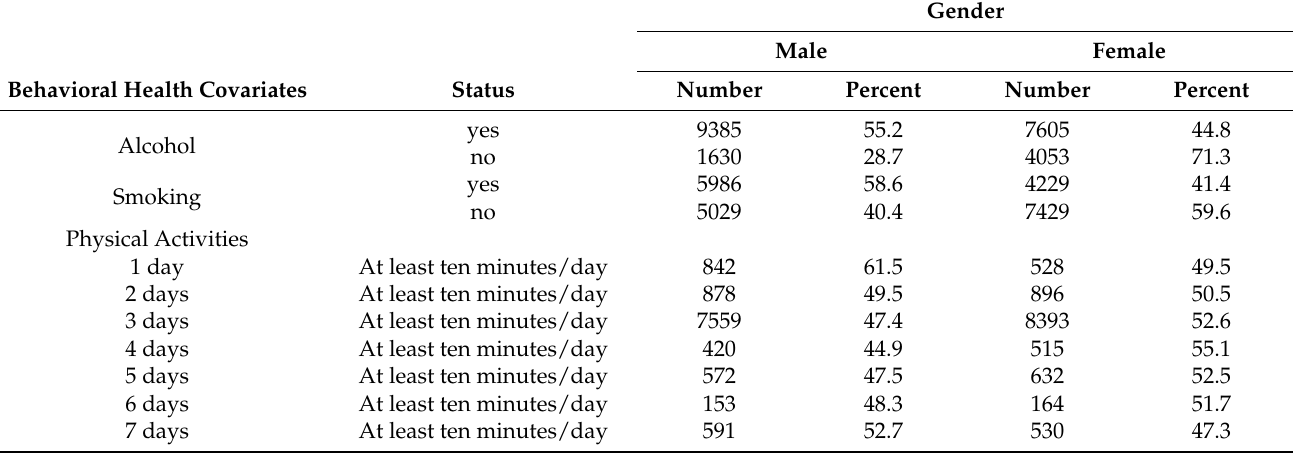
The summary statistics of the behavioral health covariates for participants (Table 7) gives context to these findings by gender. Table 7. The composition and percentage of the behavioral health covariates for the